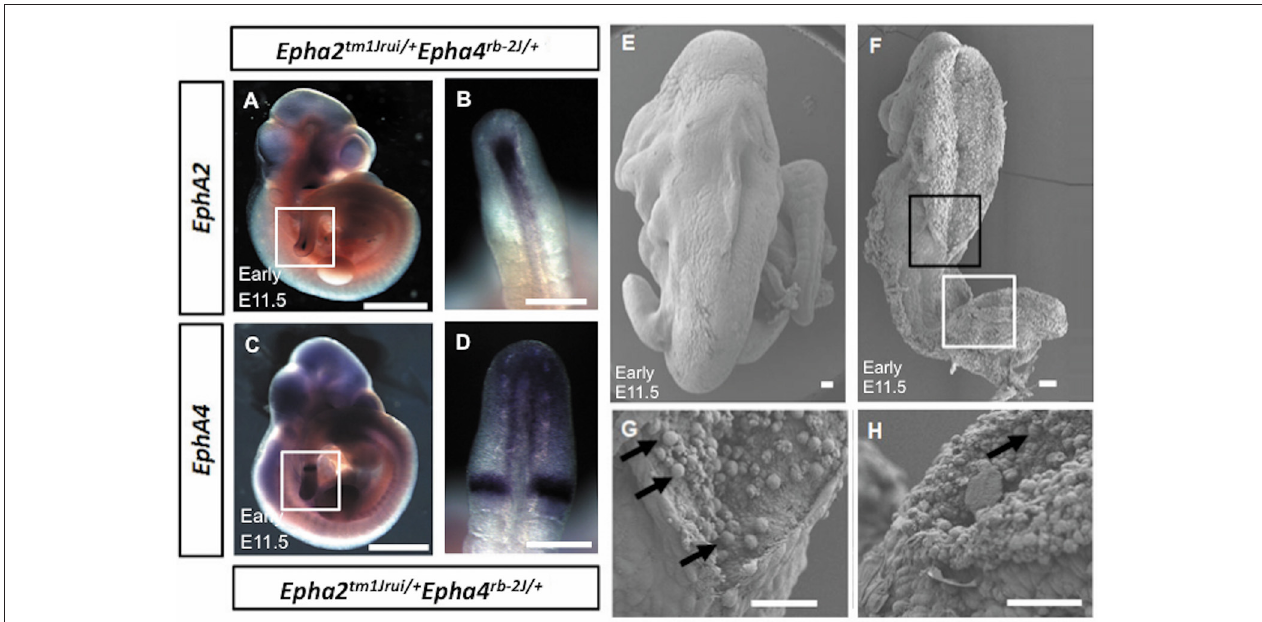
FIGURE 2 | (A–D) Absence of expression of EphA2 and EphA4 at the point of adhesion and fusion in early E11.5 Epha2 tm 1 Jrui / + Epha4 rb − 2 J / + embryos. The expression of EphA2 (A,B) and EphA4 (C,D) in the posterior neuropore of Epha2 tm 1 Jrui / + Epha4 rb − 2 J / + but absence of EphA2 and EphA4 expression at the point of adhesion and fusion in the double heterozygotes respectively. White box in (A,C) represents the magnified version of the posterior neuropore as seen in B and D respectively. (E–H) Scanning electron micrograph of the axial rotation defect embryo ( Figure 1M ). (E) Scanning electron micrograph of a wild-type littermate of Figure 1M (E11.5). (F) The anterior (black box) and posterior (white box) neural tube of the early E11.5 embryo is open. (G,H) . Close ups of the closing point at the thoracic region (G) and opening site of the neural tube in the spinal region (H) respectively. The arrows in G represent potential apoptotic cells. Scale bar (A–D) : 1mm; (E–H) : 0.05